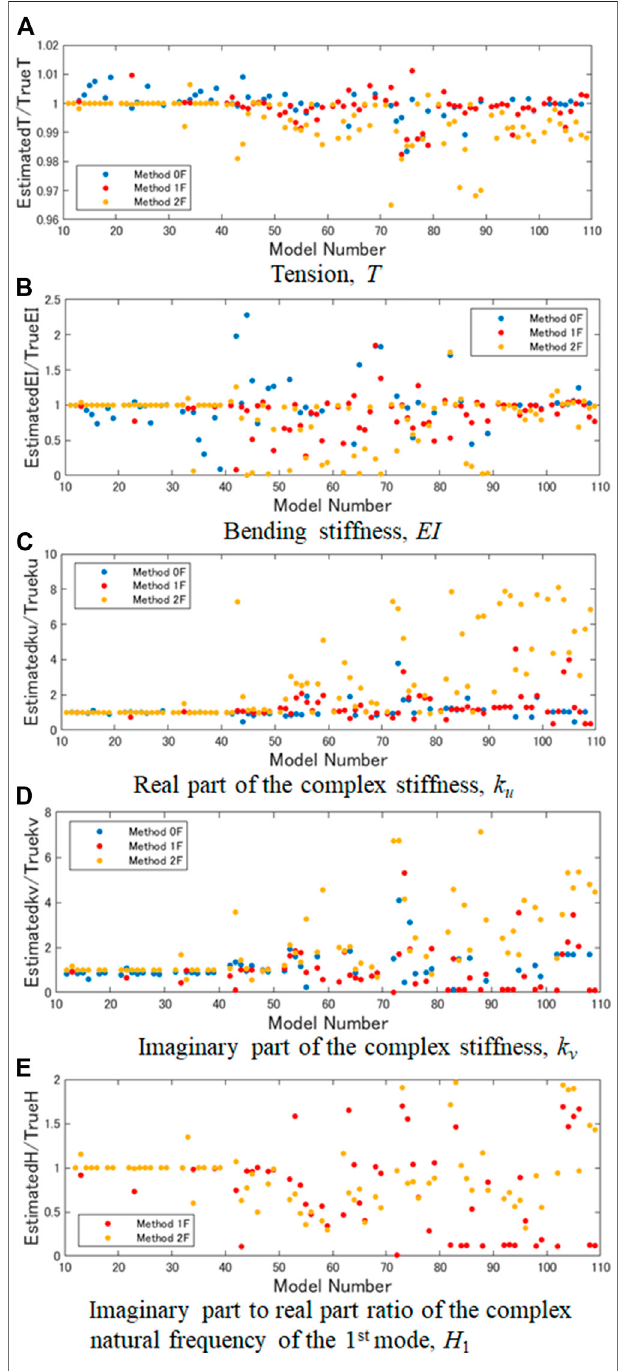
FIGURE 3 | Estimation results for a cable with a high-damping rubber damper: (A) tension, T ; (B) bending stiffness, EI ; (C) real part of complex stiffness, k u ; (D) imaginary part of complex stiffness, k v ; (E) imaginary part to real part ratio of complex natural frequency of 1 st mode, H 1 .